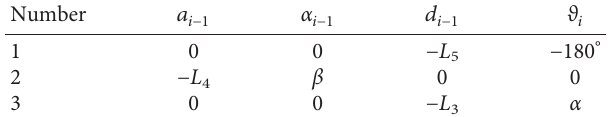
Table 2: The D-H model real parameters.